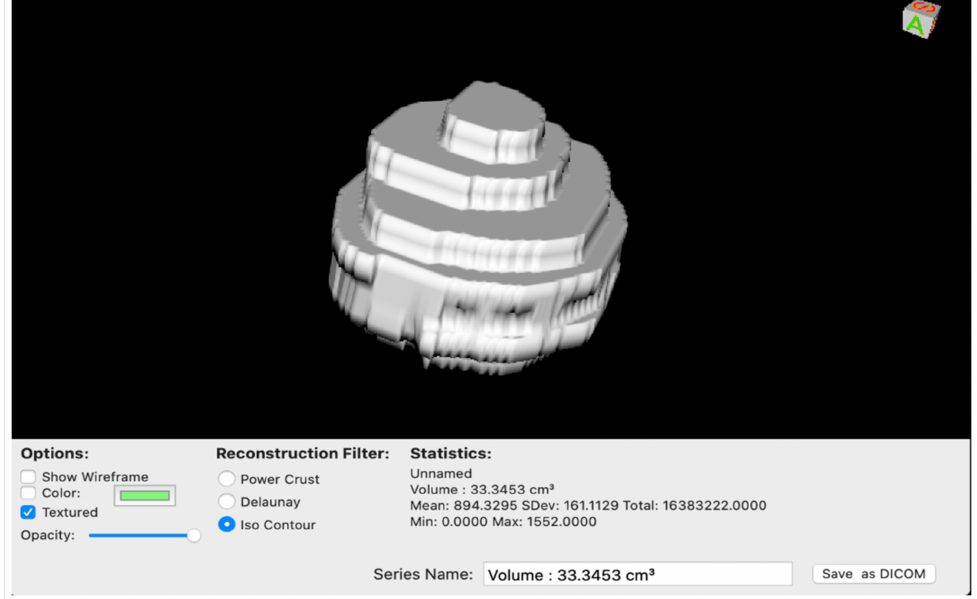
Figure 2. The ROI volume of the tumor was rendered in a 3D model before subtracting from T2-weighted sequences to obtain the volume of the